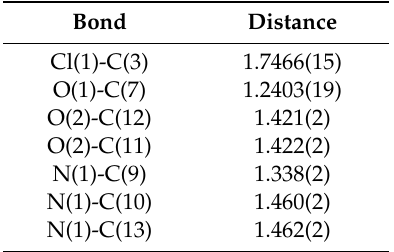
Table 1. Selected bond lengths [Å] and angles [ ◦ ] for 1